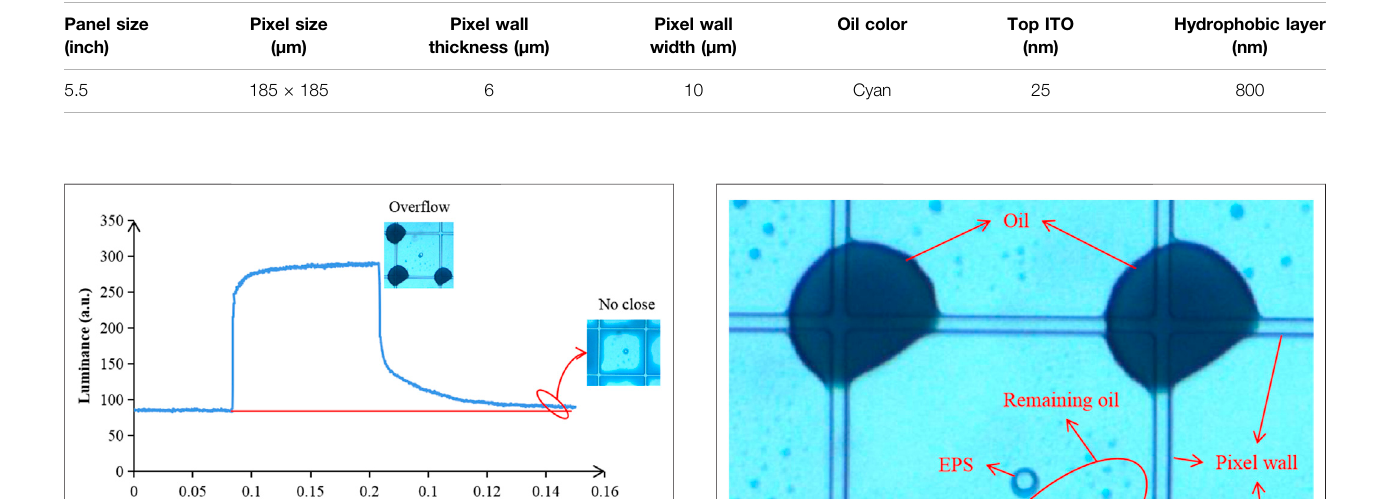
TABLE 1 | Parameters of the EWD panel.